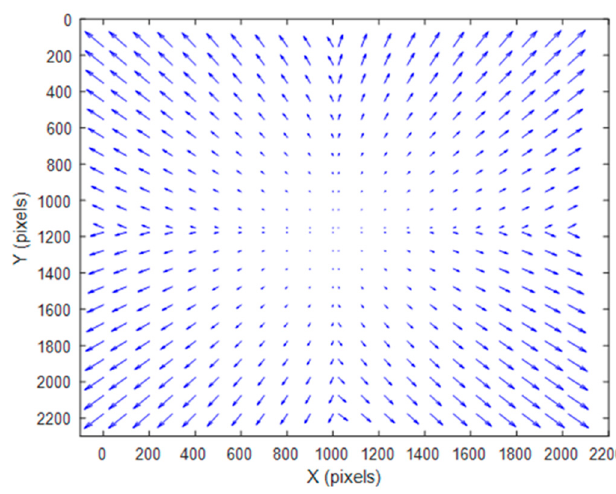
Figure 9. Distortion calibration plot of the single-camera four-view 3D-DIC system. The static experiment configuration is shown in Figure 6a. Artificial speckles are generated on the surface of the specimen in Figure 6b. The working distance between the specimen and the prism is 200 mm. Twenty-five images are captured by the single four-view camera system and calculated by DIC. In detail, VIEW 1 and VIEW 2 are used to construct a conventional two-view DIC, and all four views are combined to provide a four-view DIC measurement. The standard deviation error of displacement for di ff erent directions (DX, DY, and DZ) are shown in Figure 10, respectively. Practically, the random error is represented by the standard deviation error. It is noticed that four-view DIC shows a distinct improvement in the random error. Compared to the two-view measure- ment, the in-plane displacement random error of the four-view measurement is reduced by 0.0004 mm. For out-of-plane displacement random error, it is reduced from 0.0035 mm to 0.002 mm. It can be noticed that the random error is obviously reduced by the strong geometric constraints of four views.